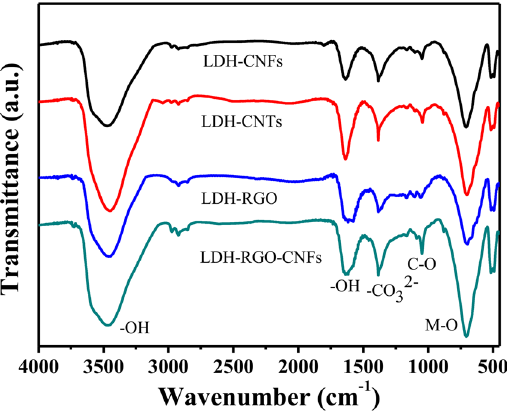
Figure 2. FT-IR spectra of LDH-CNFs, LDH-CNTs, LDH-RGO and